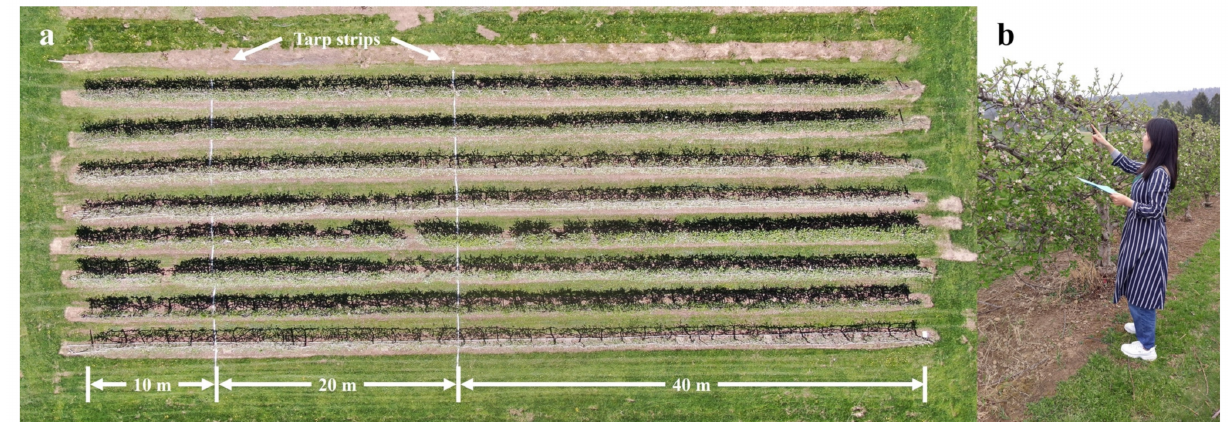
Figure 2. Illustration of manual apple blossom counting during the field experiment: ( a ) top view of the apple orchard showing the tarp strips, which divided each tree row into three sections; ( b ) blossom counting of one side of a tree row section.